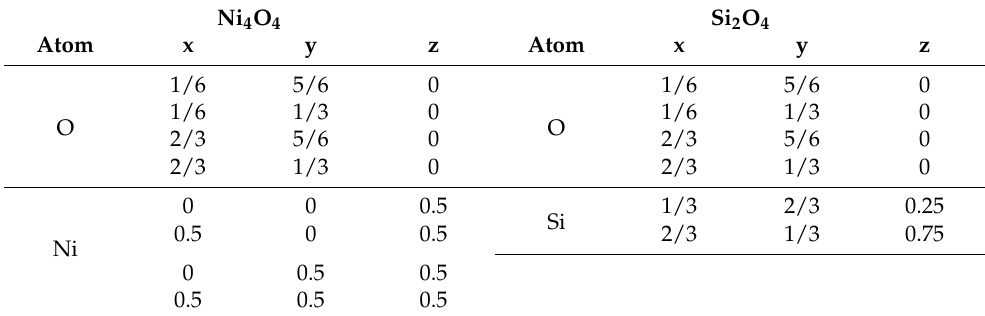
Table 2. Coordinates of atoms in hexagonal unit cells of octahedral Ni 4 O 4 and tetrahedral Si 2 O 4 layers.